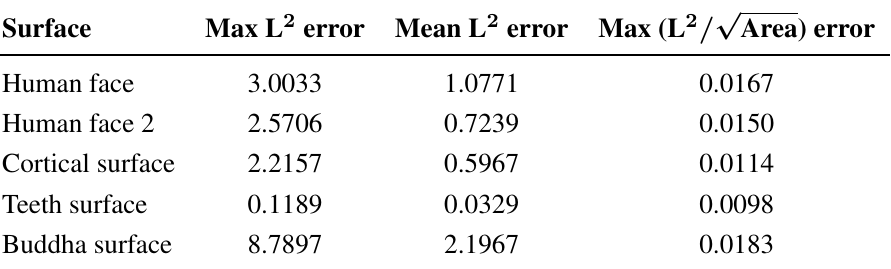
Table 1. Summary of the λ − H reconstruction